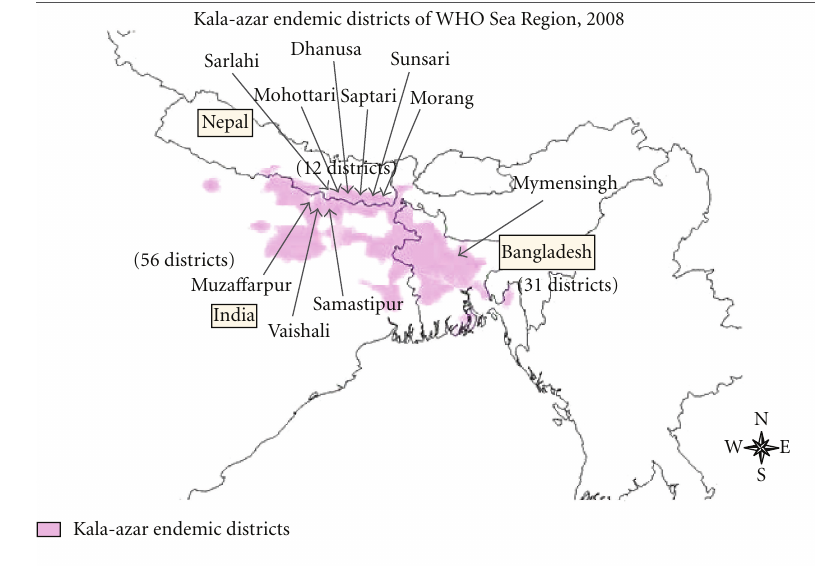
Figure 2: Study area map.